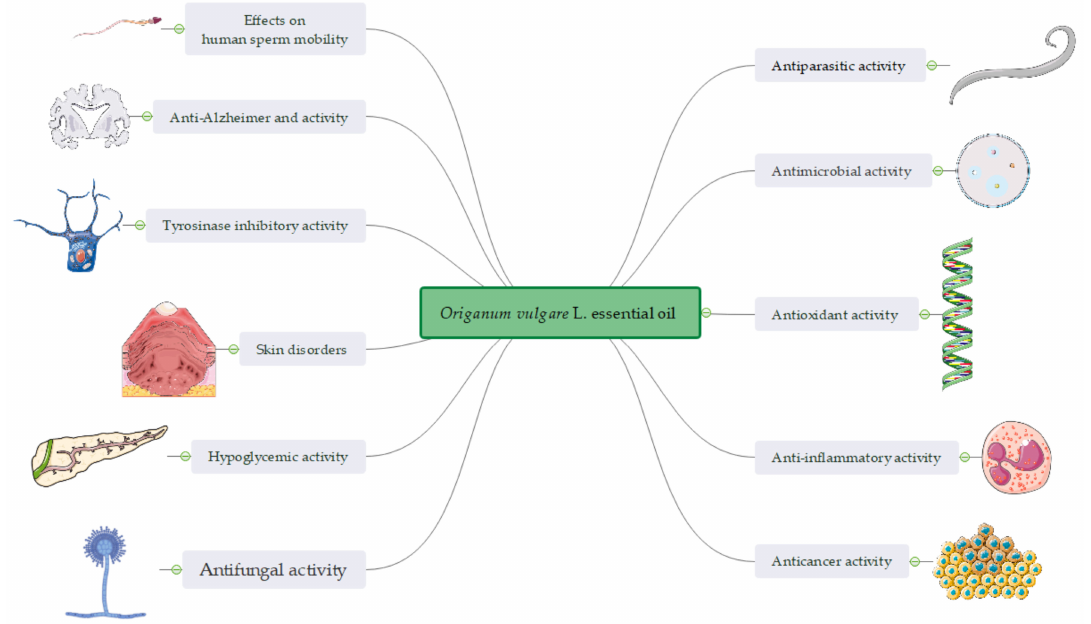
Figure 3. A snapshot of the bioactivity of Origanum vulgare L. essential